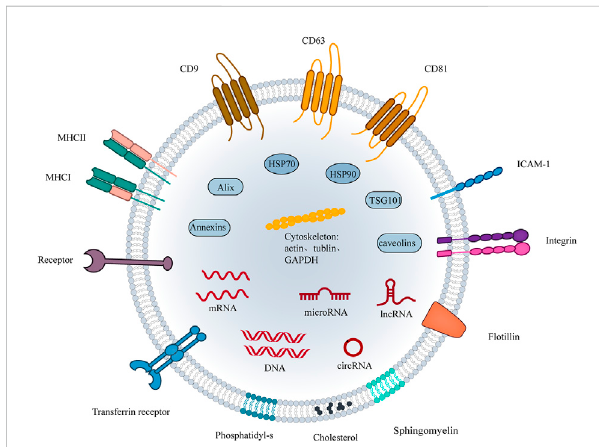
The structure of small EVs. The components of small EVs consist of three main groups of substances. (1) Proteins: four transmembrane protein superfamily: CD9, CD81, CD63, etc; Heat shock proteins: HSP70 and HSP90; Cytoskeletal proteins: actin, tubulin, etc; Adhesion proteins: ICAM1, integrins and transferrin; Antigen presentation: MHC- Ⅰ , MHC- Ⅱ ,CD86. Among them, CD9, CD81, CD63, fl otillin, TSG101, ceramide, and Alix are currently considered markers of small EVs. (2) Nucleic acids: DNA, mRNA, miRNA, and other